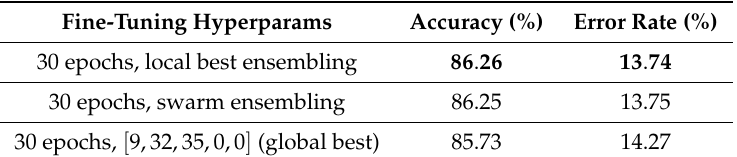
Table 3. Performance measures on the CIFAR-10 test set for 30 fine-tuning epochs following optimisation using the BLSK-S weight inheritance method. With the best results highlighted in